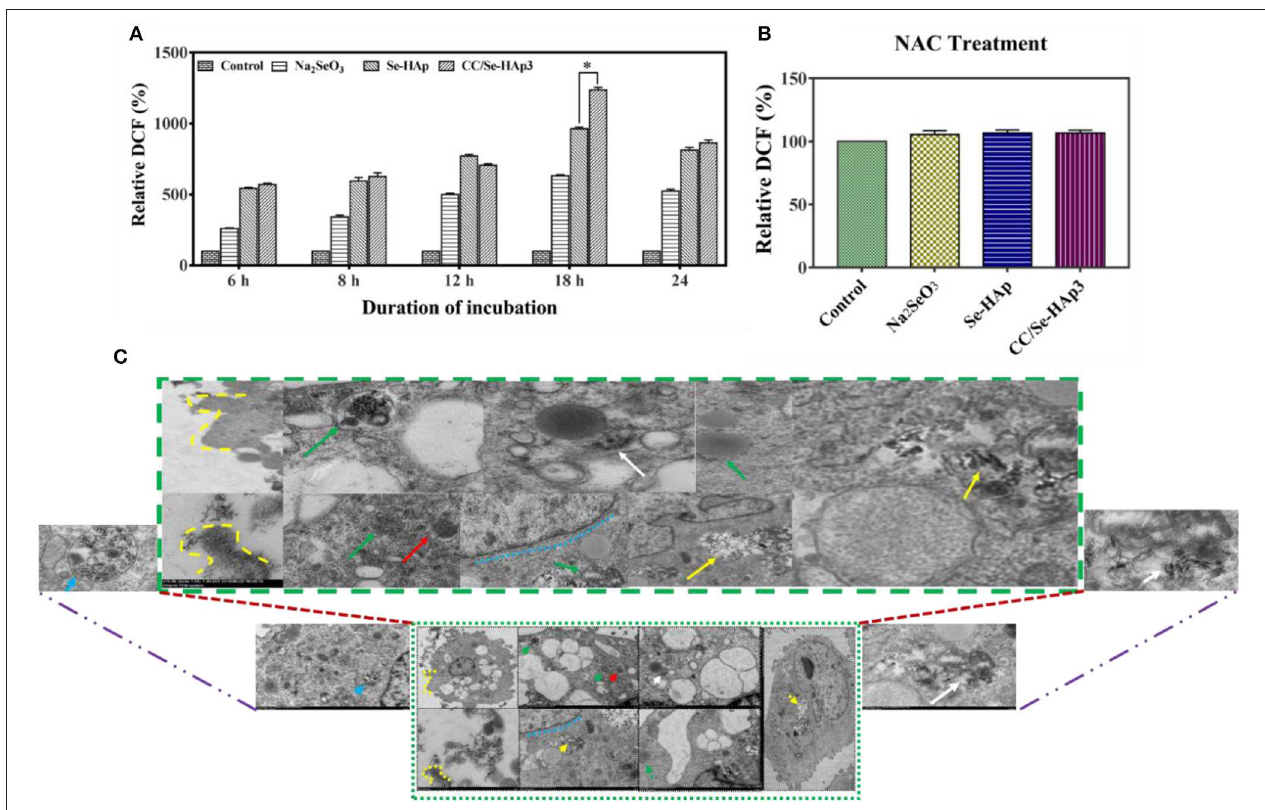
FIGURE 6 | ROS generation and internalization of nanoparticles. (A) Relative fluorescence intensity of DCF (percent) generated during the process of ROS formation demonstrated that CC/Se-HAp exhibited a remarkable increase in DCF, as compared to Se-HAp or Na 2 SeO 3 . (B) Relative fluorescence intensity of DCF (percent) in presence of ROS inhibitor was non-detectable in presence of both catechin and selenium. (C) TEM micrographs illustrating the internalization of CC/Se-HAp nanomaterials into the human osteosarcoma cell through a typical endocytosis process. TEM images show that the nanoparticles were internalized by human osteosarcoma cells through a typical endocytosis process. Yellow dotted lines describe cell membrane invagination that is followed by endosome formation. Red arrows specifying region indicates newly generated endosomes loaded with nanoparticles. Green arrows determine the primary lysosome combined with the endosome. White arrows denote the degradation and release of active agents. Blue arrows represent the noticeable degradation of nanoparticles within the lysosome (secondary). Yellow arrows represent the nanoparticles in the vicinity of the nucleus (probably lysosomal disruption). * p < 0.01 indicates significant differences of ROS generation in response to CC/Se-HAp treatment in comparison with Se-HAp